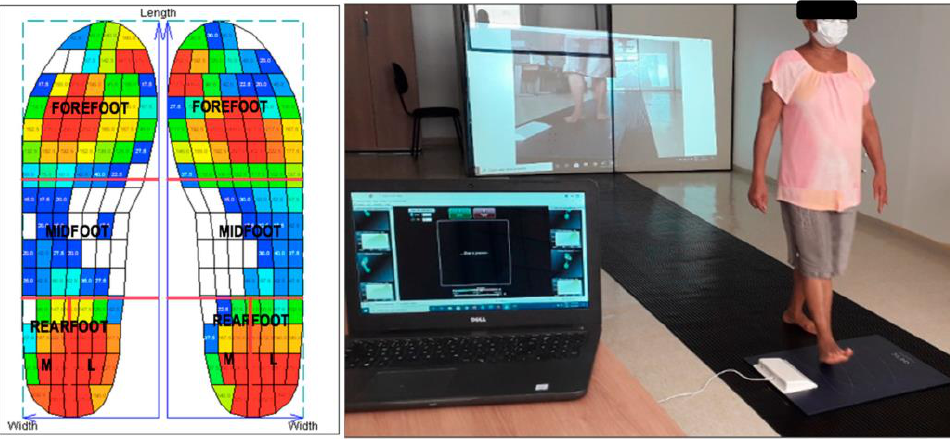
Figure 2. Analysis of plantar pressure distribution and division of foot areas.